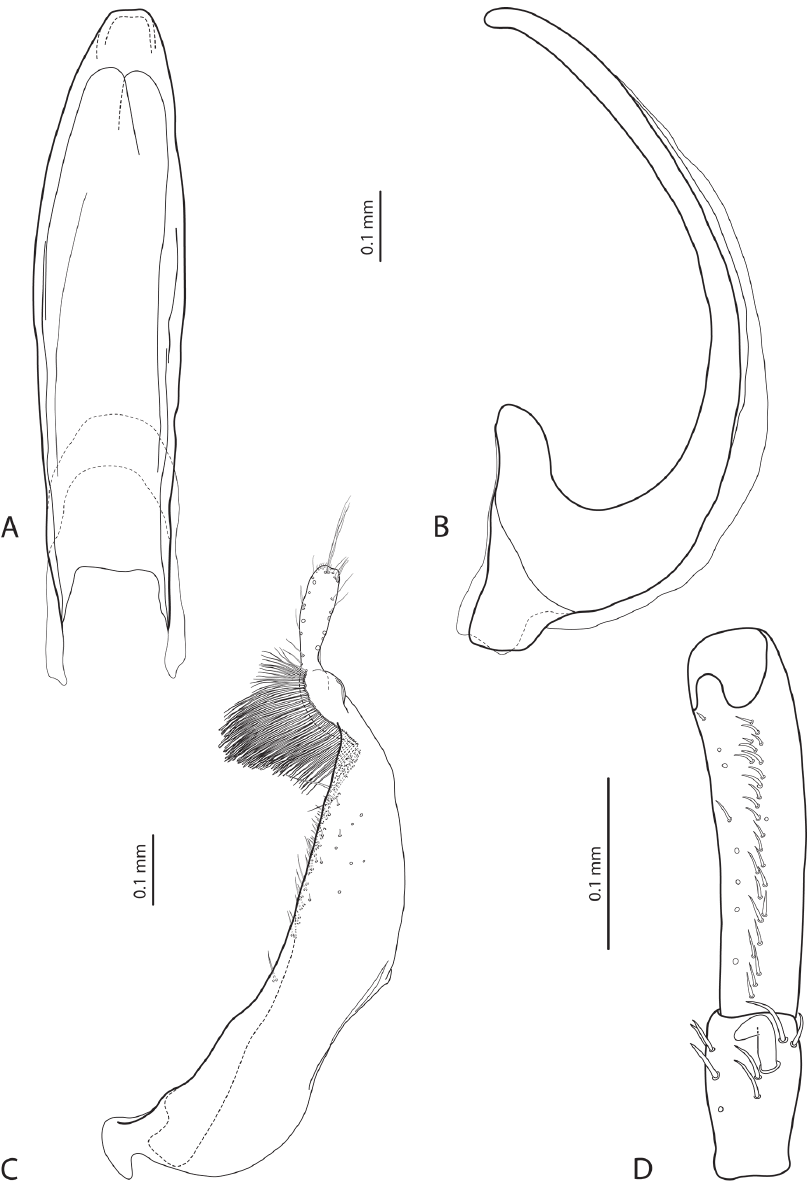
Figure 5. Exocelina okbapensis sp. n. A median lobe in ventral view B median lobe in lateral view C paramere in external view D male protarsomeres 4–5 in ventral view. and elytra with evident microreticulation, dorsal surface more or less shiny to submatt. Head with microreticulation stronger. Metaventrite and metacoxa distinctly microre- ticulate, metacoxal plates with longitudinal strioles and transverse wrinkles. Abdominal ventrites with distinct microreticulation, strioles, and very fine sparse